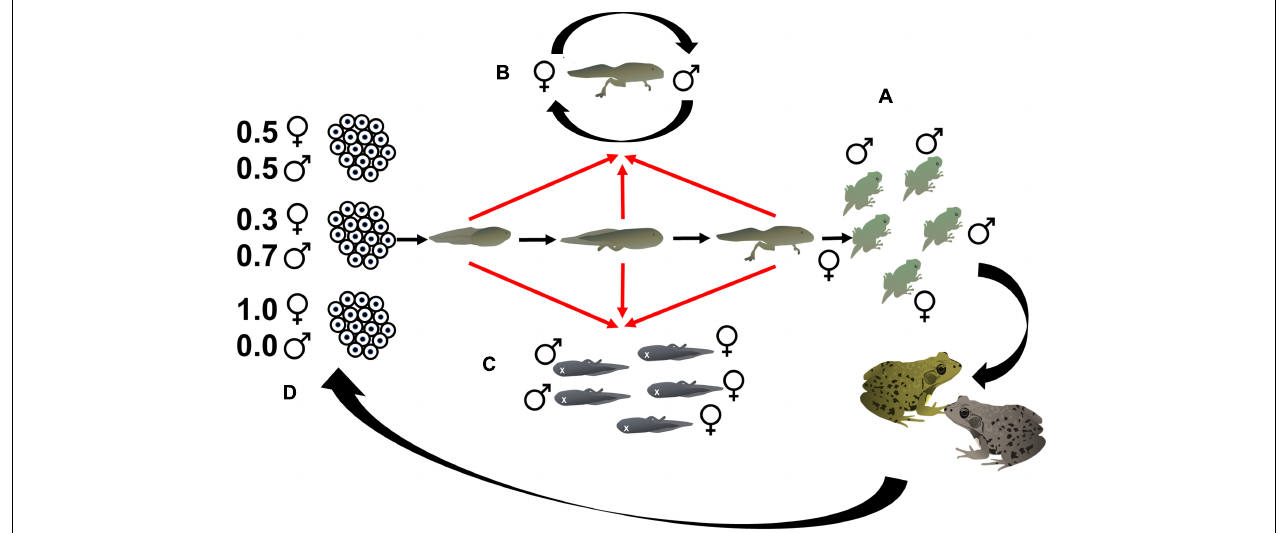
FIGURE 1 | Phenotypic sex ratios (A) in metamorphosing tadpoles may have contributions from the direct effect of sex reversal as tadpoles develop (B) , the effects of genotypic sex-biased mortality (C) , and indirect effects of sex reversal whereby sex-reversed adults breed and produce clutches with skewed genotypic sex ratios that bias entire cohort sex ratios (D)